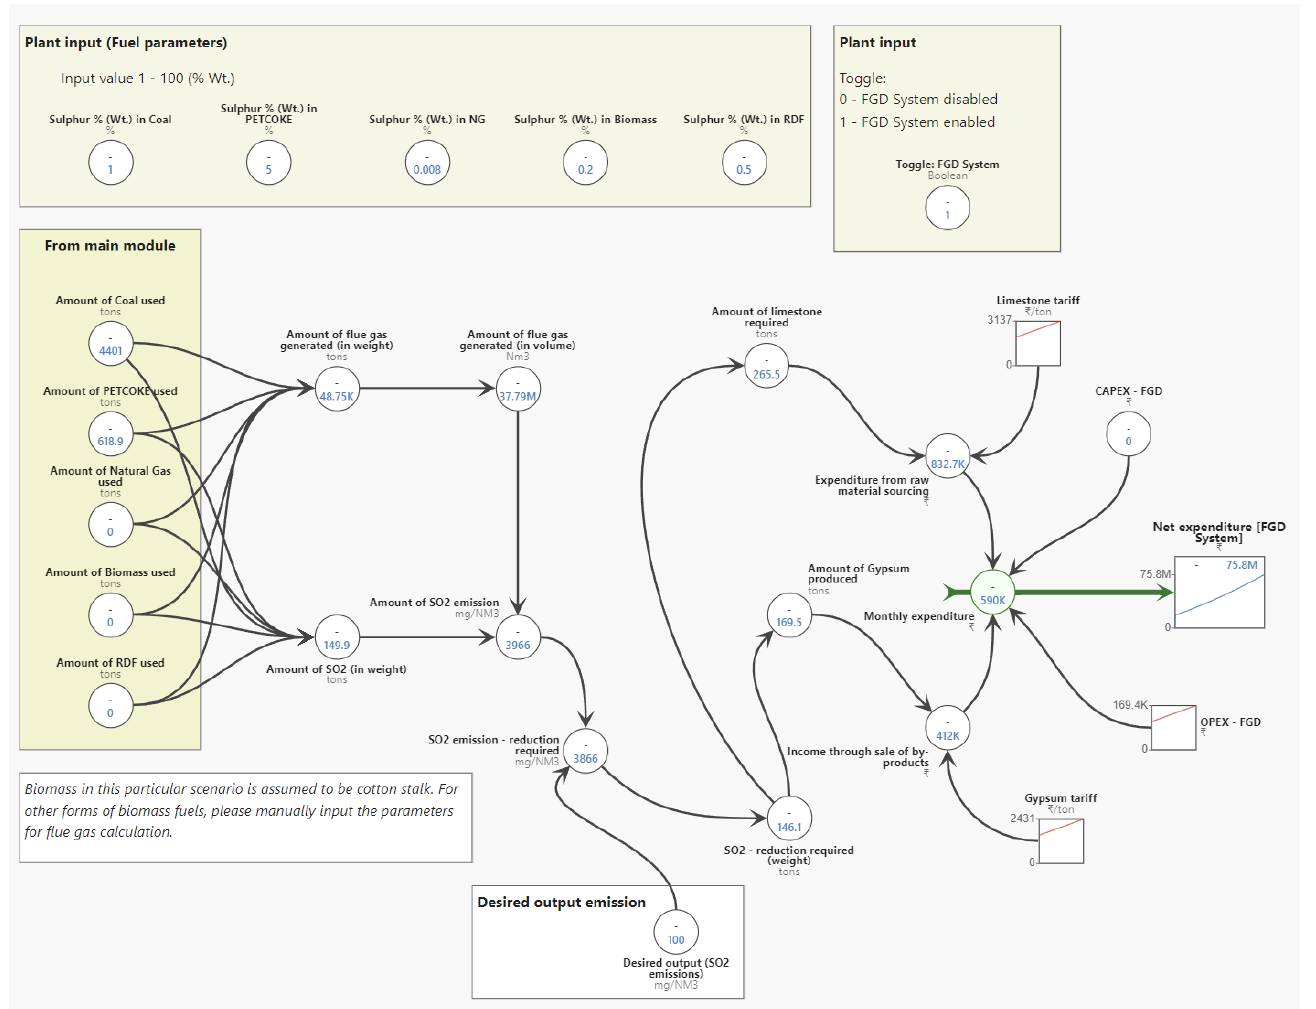
Figure A1. Stock-and-flow diagram of the flue-gas desulphurisation system. Table A2. Description of the variables used in the FGD Module.